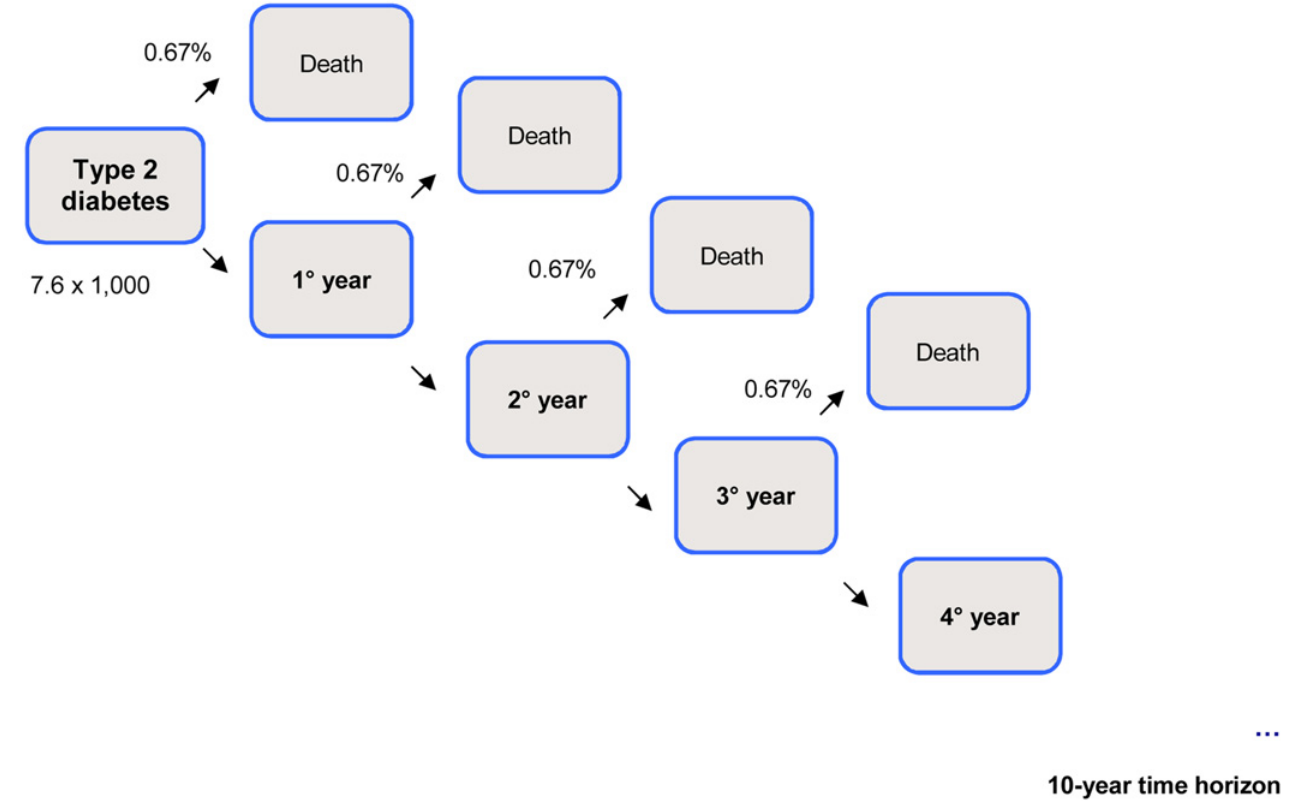
Fig 1. Schematic representation of first 4 years ’ model: type 2